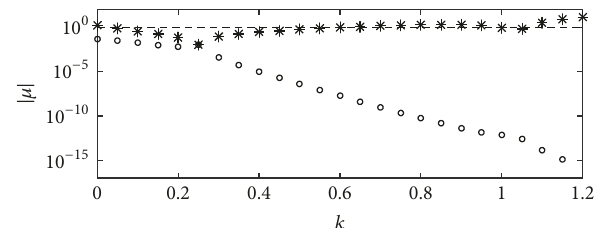
Figure 8: Magnitude of the two Floquet multipliers for different values of 𝑘 for the TUPO1 controlled by the